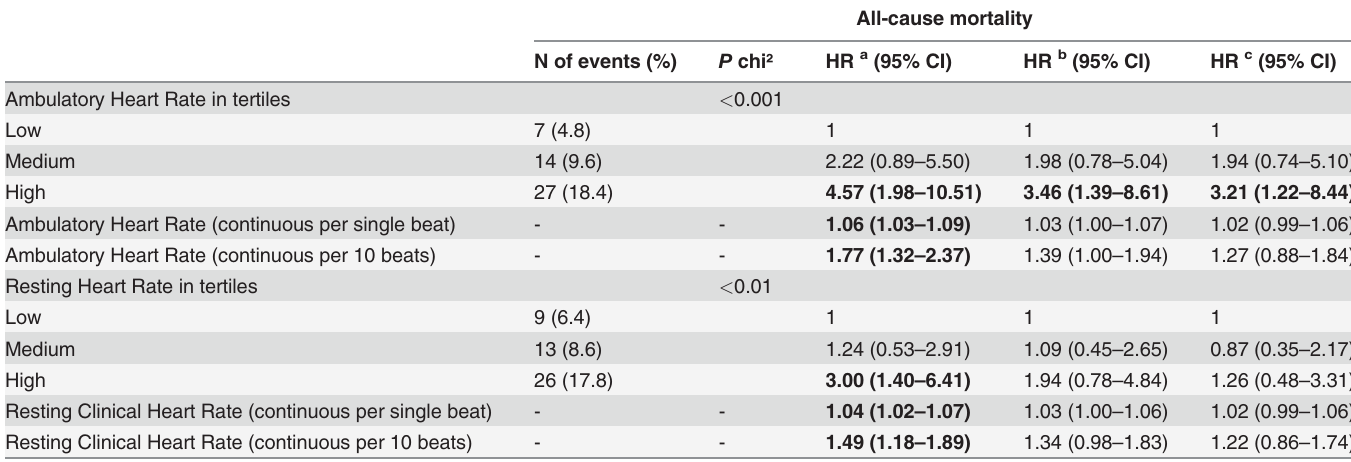
Table 2. Associations between continuous and categorized resting clinical and average continuously measured 24-hour ambulatory heart rate and all-cause mortality in 439